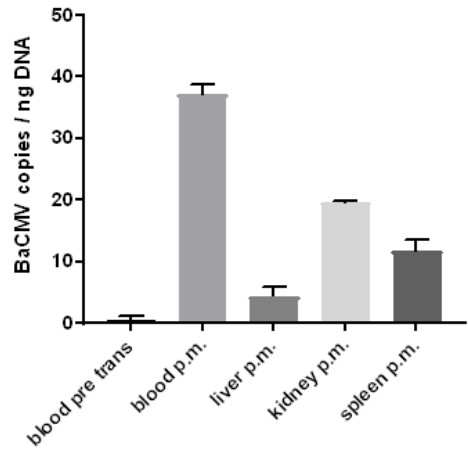
Figure 7. Prevalence of BaCMV in different organs of baboon 64. The comparison of the copy numbers of the virus in the blood before transplantation (blood pre trans) and after transplantation (post mortem, p.m.) clearly demonstrates the replication (activation) of BaCMV. In addition, the copy numbers in different organs at the end of the experiment were determined. For understandable reasons, the copy numbers in the organs before transplantation were not available.